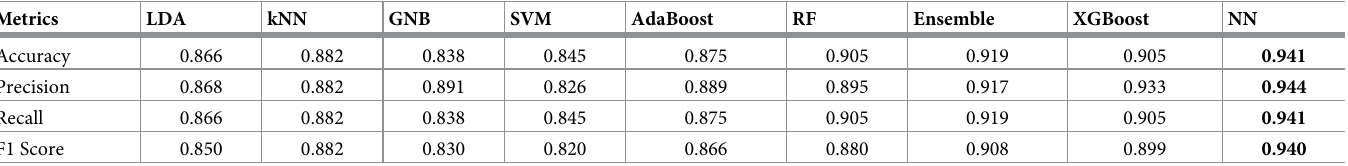
Table 8. Classification accuracy obtained using selected handcrafted, radiomic and deep features. Metrics